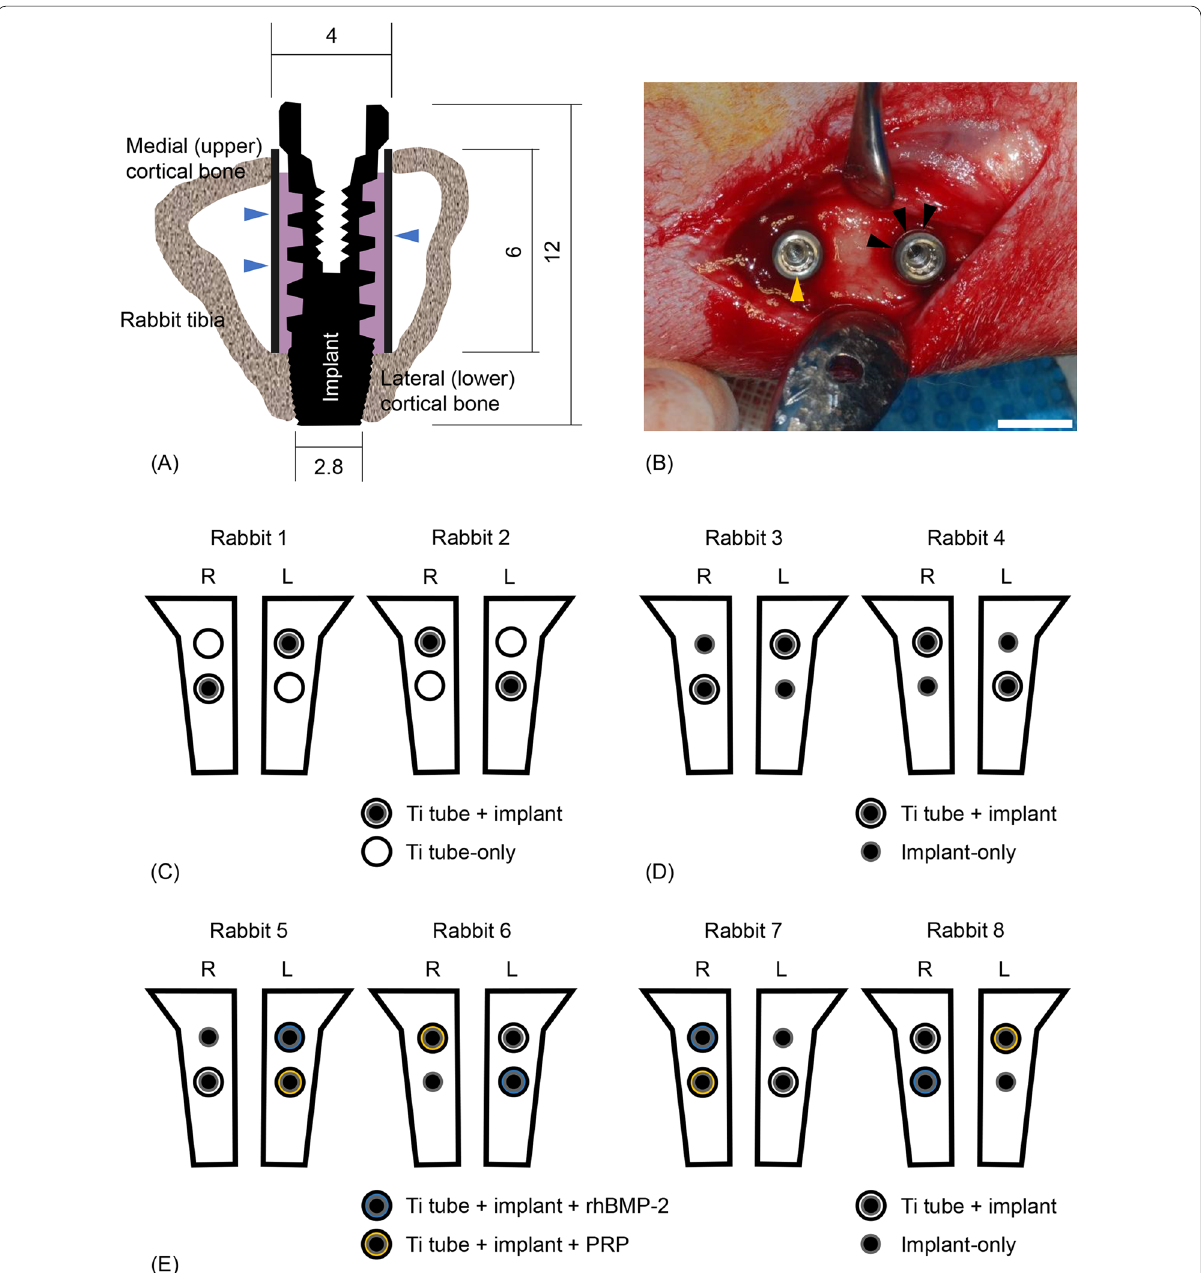
Fig. 1 A Schematic drawing of an implant and tube (blue arrowheads) inserted into a rabbit tibia. The tibia was drilled bicortically, the tube was inserted into the upper cortical bone, and the implant was inserted through the tube into the lower cortical bone. The gap (pink area) between the implant and the tube allowed blood flow from the lower cortical bone. Numbers indicate dimensions in millimetres. B Two implants were inserted into each tibia. An implant (yellow arrowhead) is shown on the left without a Ti tube, while on the right, a Ti tube (black arrowheads) is shown around the implant. Scale bar 5 mm. C Schematic diagram comparing the response of bone to implants in Ti tubes with that to Ti tubes alone. = The experimental groups were arranged in a 2 2 Latin square. D Schematic diagram of the comparison of the response of bone to implants with × or without Ti tubes. The groups were arranged in a 2 2 Latin square. E Evaluation of the effects of blood‑borne substances on bone formation. A × split‑plot design was used for this experiment. RhBMP‑2 was used in the Ti tube implant rhBMP‑2 group to represent cytokines derived from + + existing bone. PRP from each rabbit was applied to the Ti tube implant PRP group to test the effects of blood‑borne factors on bone formation. + + R right tibia, L left tibia, Ti titanium, rhBMP-2 recombinant human bone morphogenetic protein‑2, PRP platelet‑rich